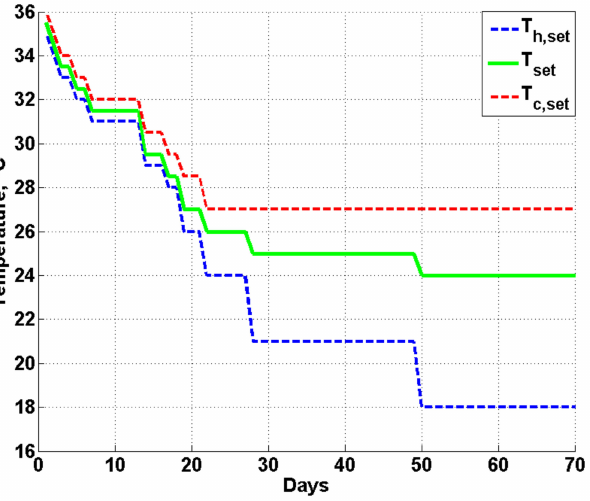
Figure 3. Indoor set temperature, T set , heating set temperature, T h,set and cooling set tempera- ture, T c,set